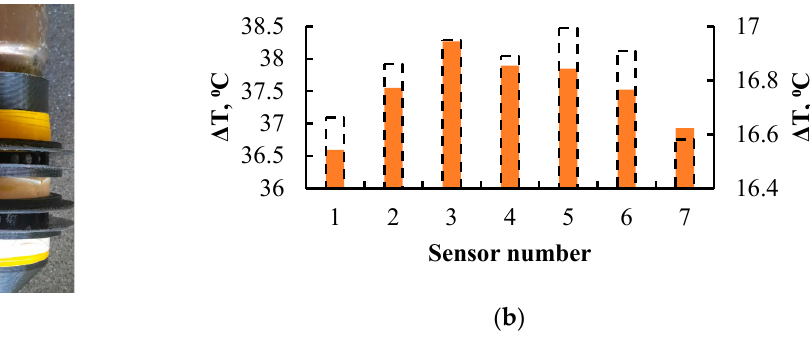
Figure 10. ( a ) Gyrotron collector sector with a heat source profiled along the longitudinal axis. ( b ) The results of the temperature distribution along the inner wall of the collector sector with a single-hump (solid) and two-hump (dash) profile of the heat source.